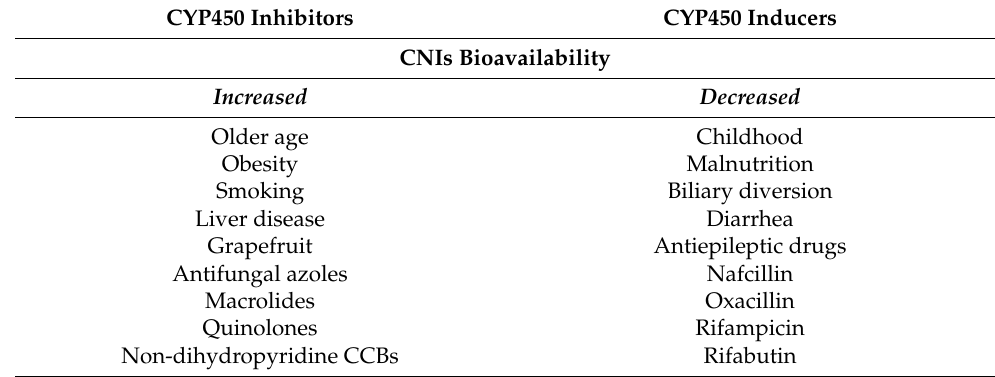
Table 1. Calcineurin inhibitors (CNIs) are metabolized in the liver by the enzymes of cytochrome P-450 (CYP450). CYP450 inhibitors increase the bioavailability of CNIs, while CYP450 inducers decrease it. CCBs, calcium channel blockers.